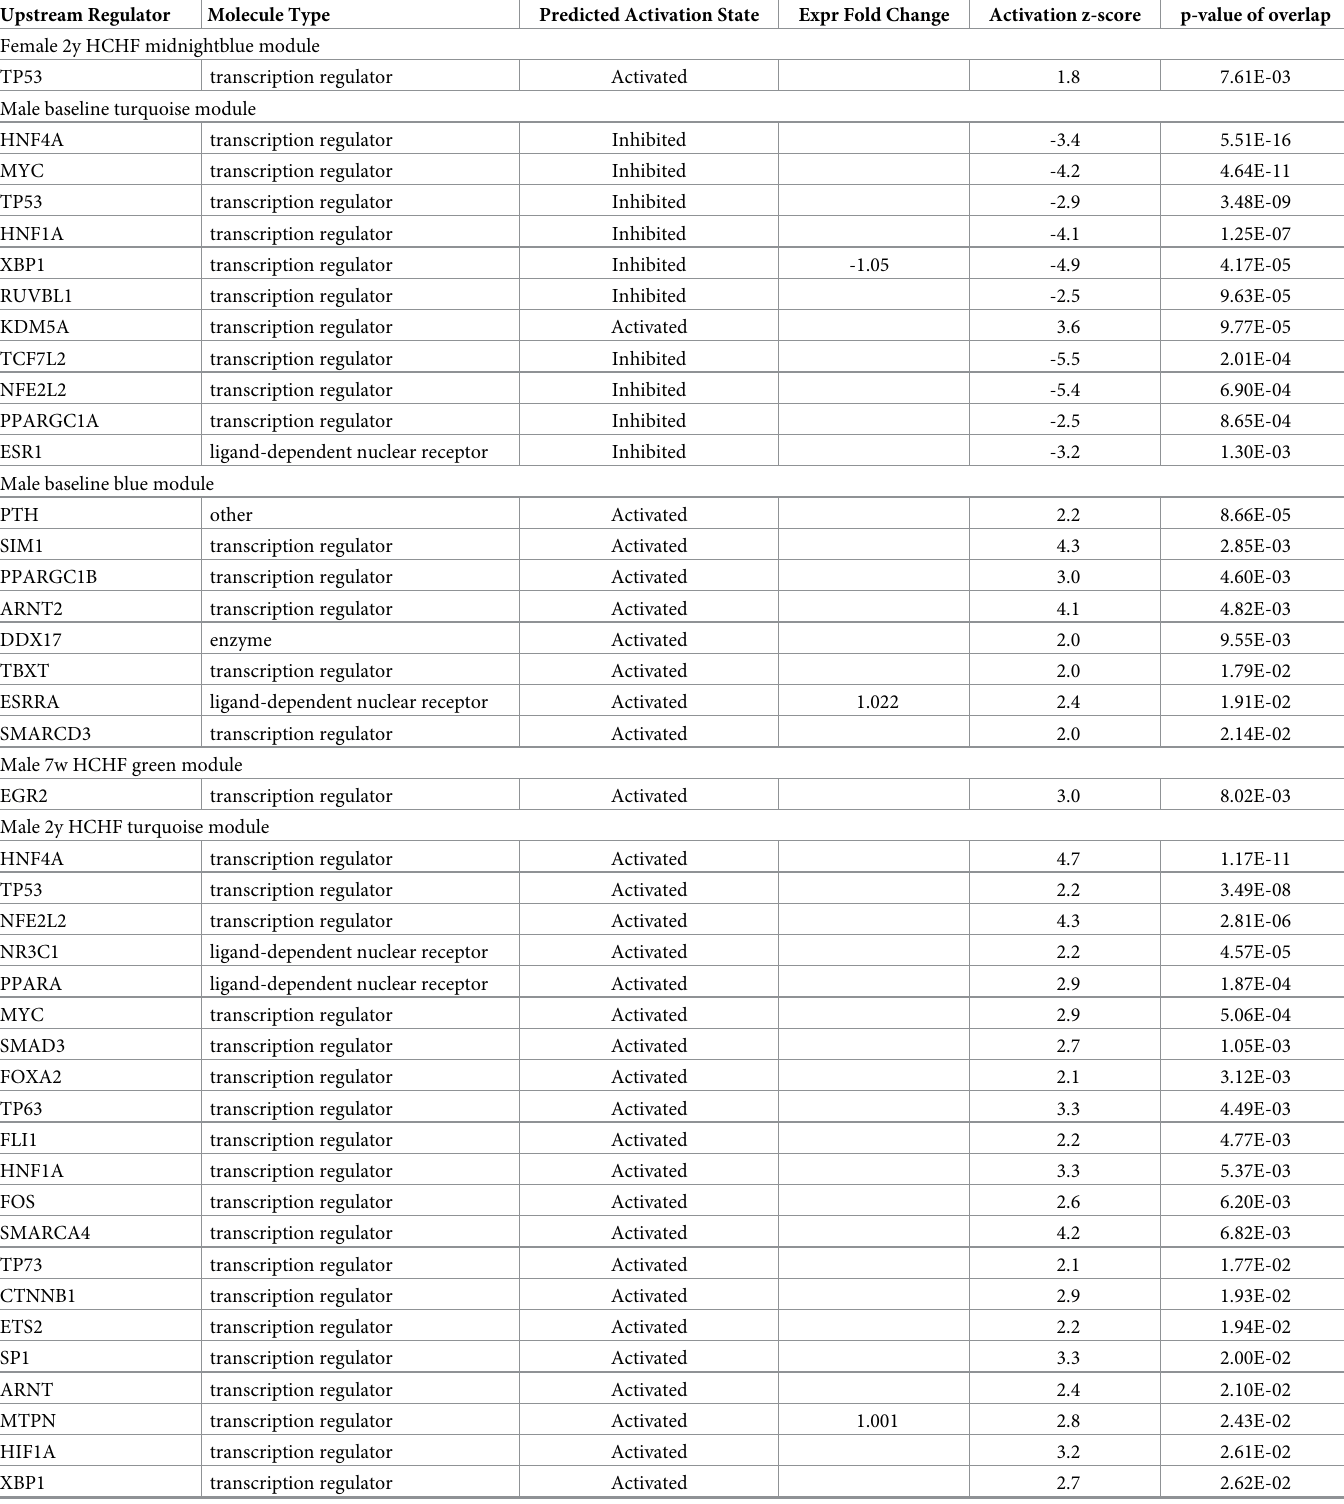
Table 4. Regulatory networks with predicted activation